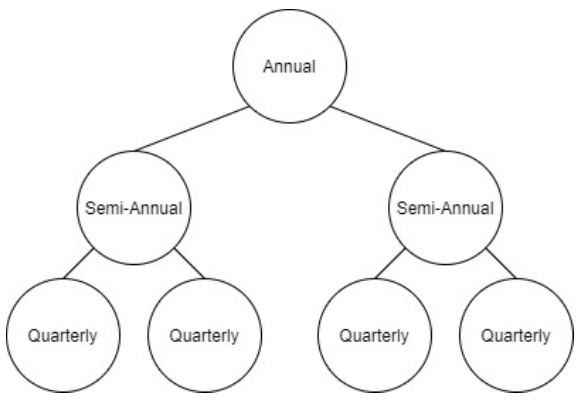
Figure 2. A temporal hierarchy for quarterly